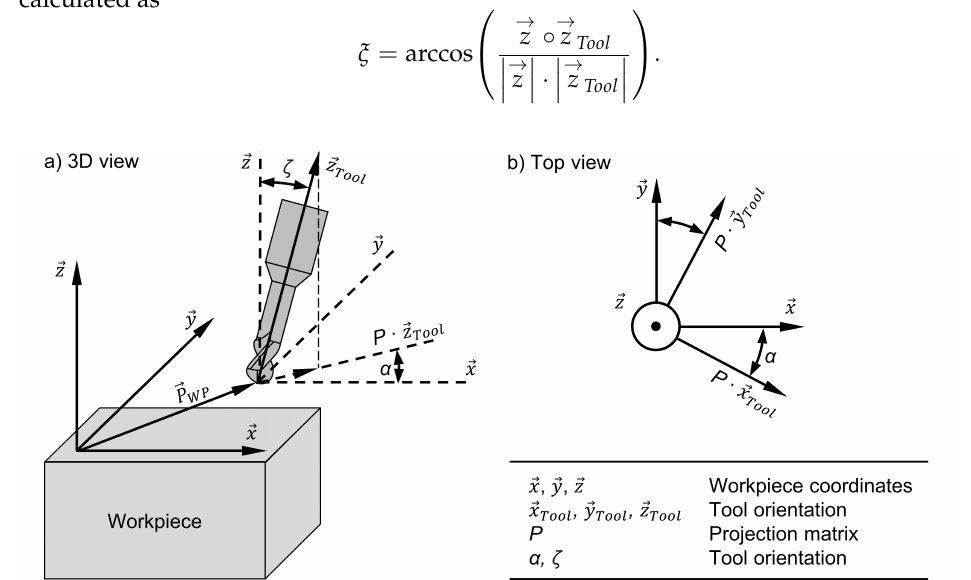
Figure 2. Description of the tool orientation in ( a ) 3D view and ( b ) top